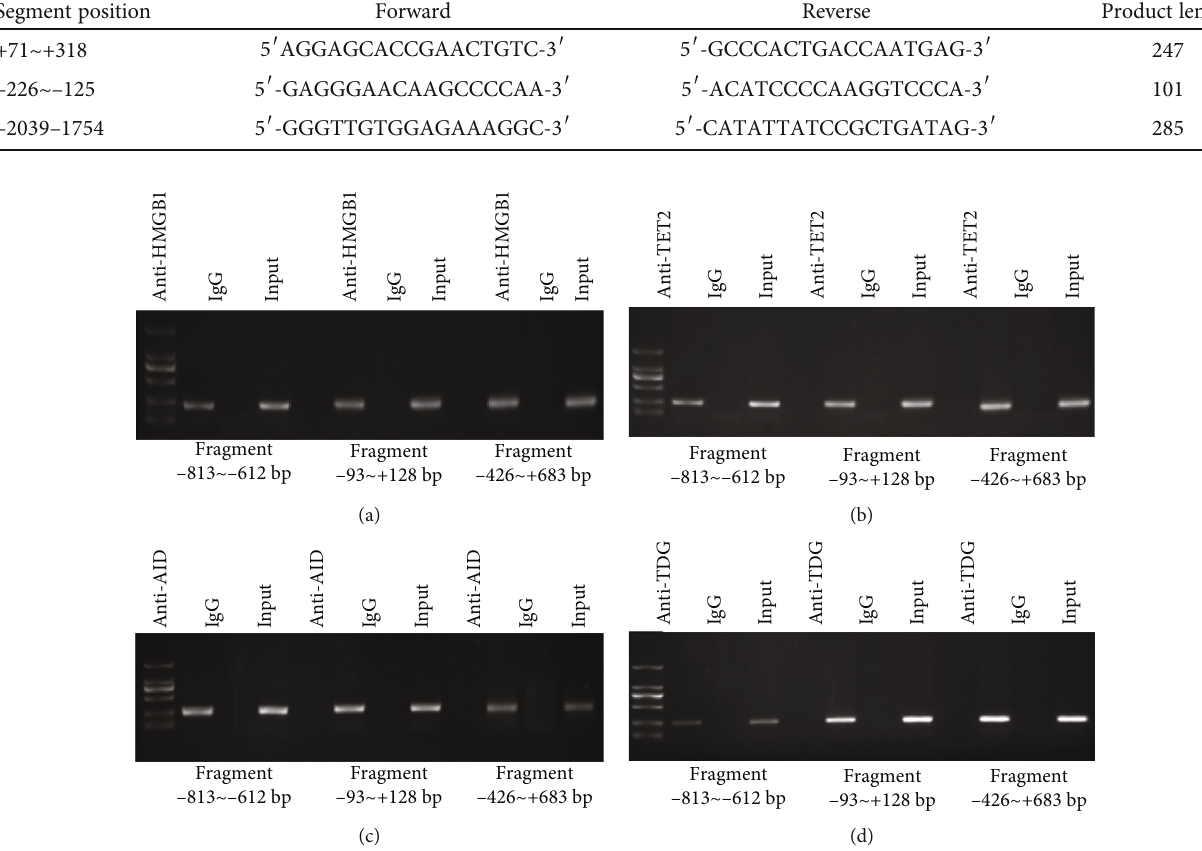
Figure 1: HMGB1, TET2, AID, and TDG were detected in STAT3 promoter. ChIP-PCR showed that HMGB1, (a) TET2, (b) AID, and (c) TDG bound to the STAT3 promoter region (-813bp to